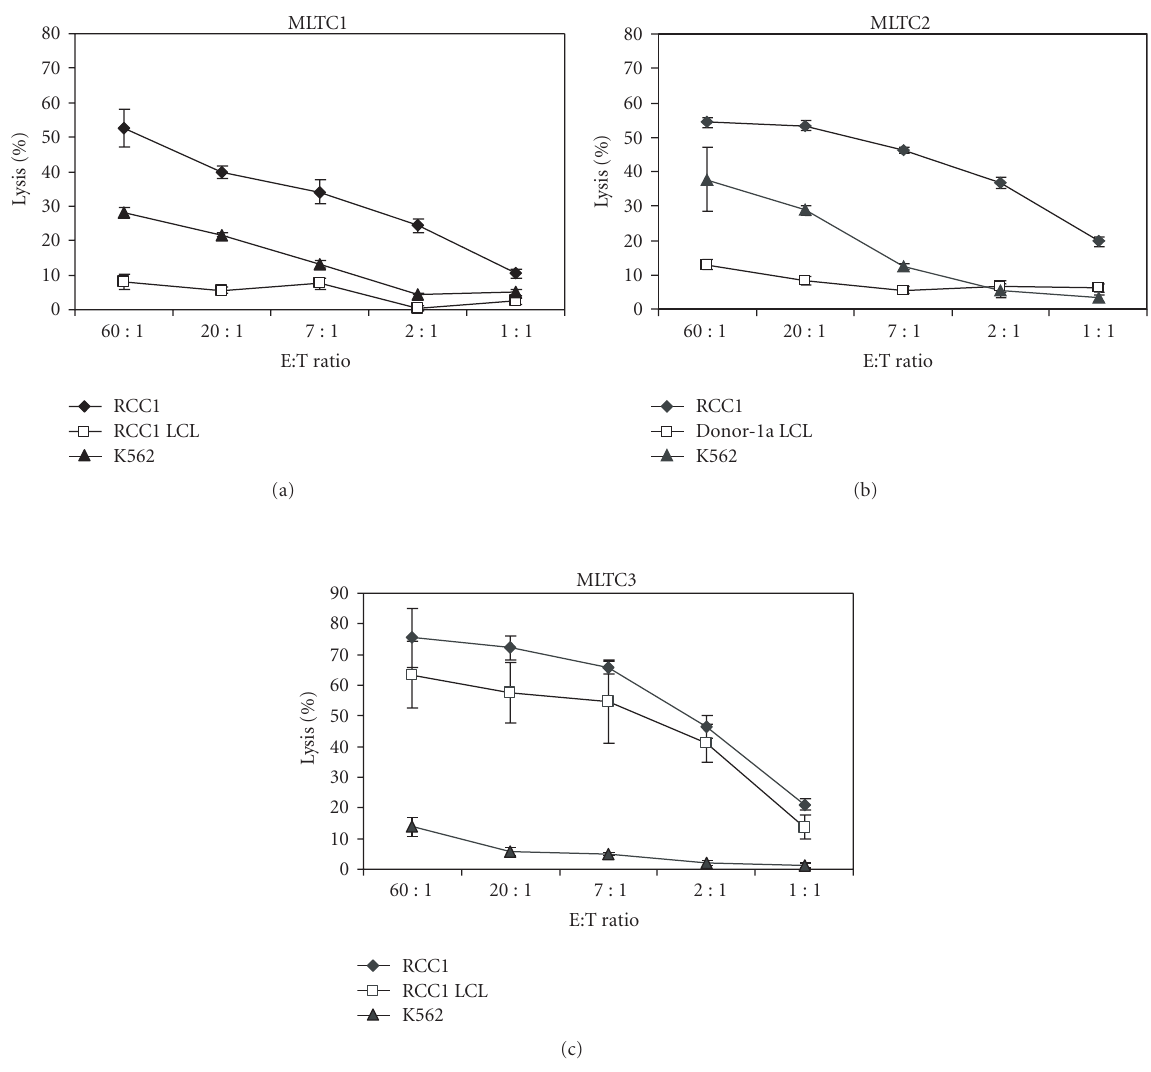
Figure 3: Cytotoxicity assay of RCC1-specific CTL at day 35 of the MLTC. Specific lysis was determined in a 4-hour 51 Cr-release assay using CD8 + T cells collected from d35 MLTC established from patient RCC1 (a) or HLA-matched normal donors (the patient’s sibling (b) and an unrelated individual (c). T cells were used at varying e ff ector-to-target (E:T) cell ratios against target cells including RCC1, K562, and RCC1-LCL. Data are presented as percentages of specific lysis ± SD.